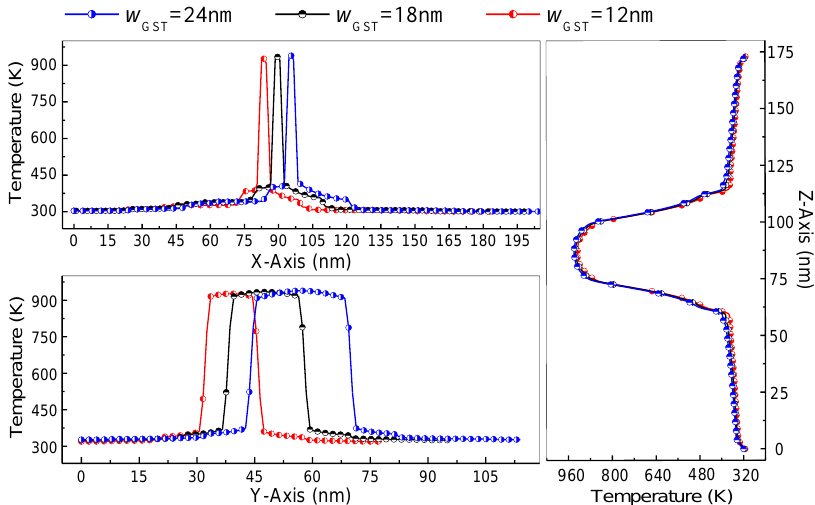
Figure 11. Temperature distributions on lines through the center point of the GST structure of the activated cell along the axis with changing w GST values.